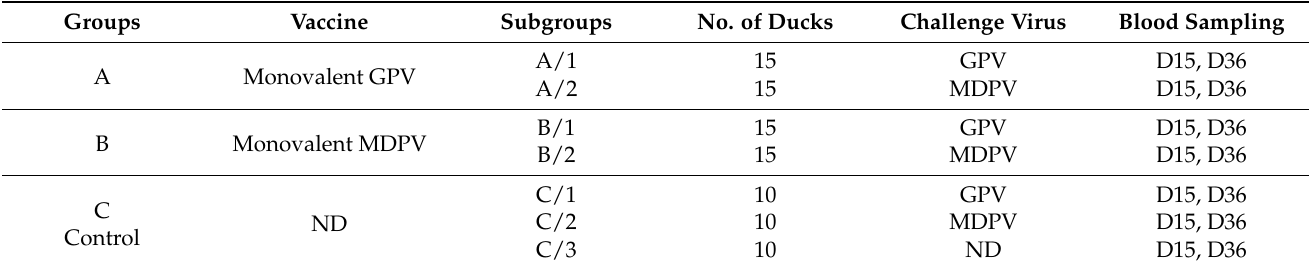
Table 1. Cross-protection experiment in MDA-free Muscovy